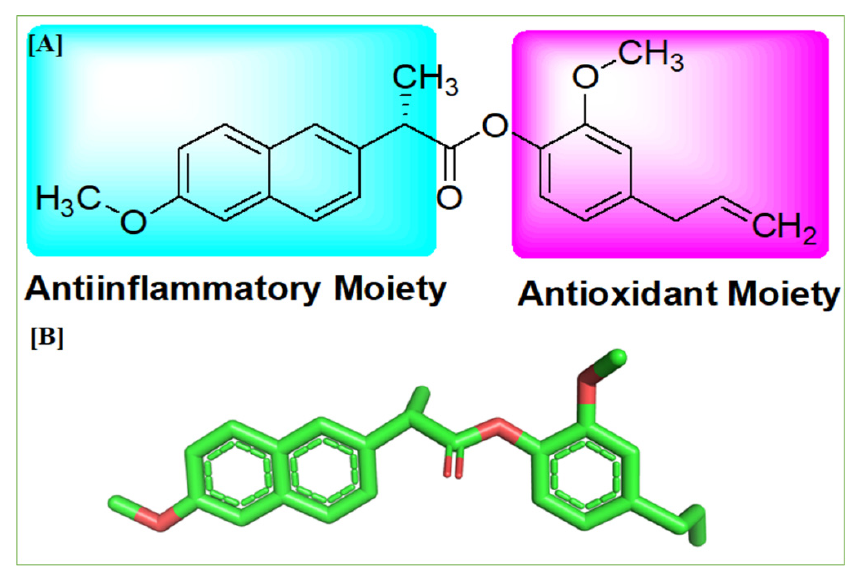
Figure 1. ( A ) Chemical structure of MAS-1696 ( 2 ). Anti-inflammatory and antioxidant scaffolds of MAS-1696 are highlighted. ( B ) Energy-minimized 3-dimensional structure of MAS-1996 ( 2 ).